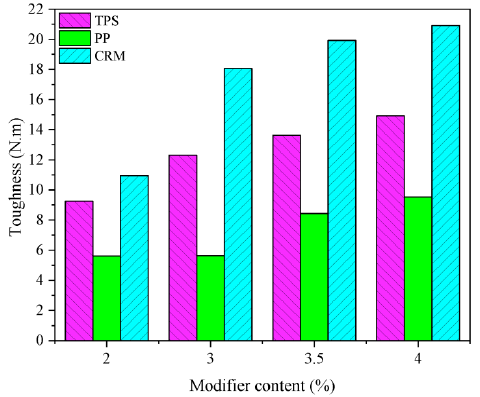
Figure 4. Effect of modifier content on toughness. Appl. Sci. 2019 , 9 , x FOR PEER REVIEW